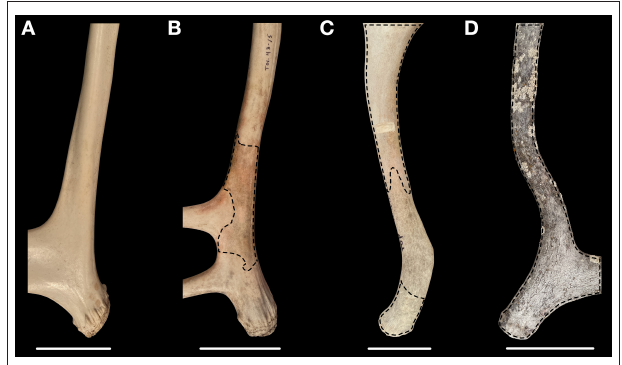
FIGURE 2 | Examples of antlers in the four weathering categories of original bone texture. (A) Bone texture score 0: preservation of more than two-thirds of original bone texture. (B) Score 1: between one- and two-thirds original bone texture preserved. (C) Score 2: less than one-third original bone texture preserved. (D) Score 3: no original bone texture preserved. Dashed lines outline regions of modified bone. In (C) , unmodified bone is difficult to visually differentiate due to discoloration, but these areas are smooth to the touch. Region sampled for 87 Sr/ 86 Sr is visible as a light colored area in the upper half of (C) . After evaluating the skyward and groundward sides of each antler, scores are added to create a Composite Score of bone texture ranging from 0 (supermajority of original bone texture preserved) to 6 (no original bone texture preserved). Scale bars are 5cm. Photographed specimens are (A) ANWR-133, (B) T01-43-15 01, (C) T01-16-12 12, and (D) T01-32-14